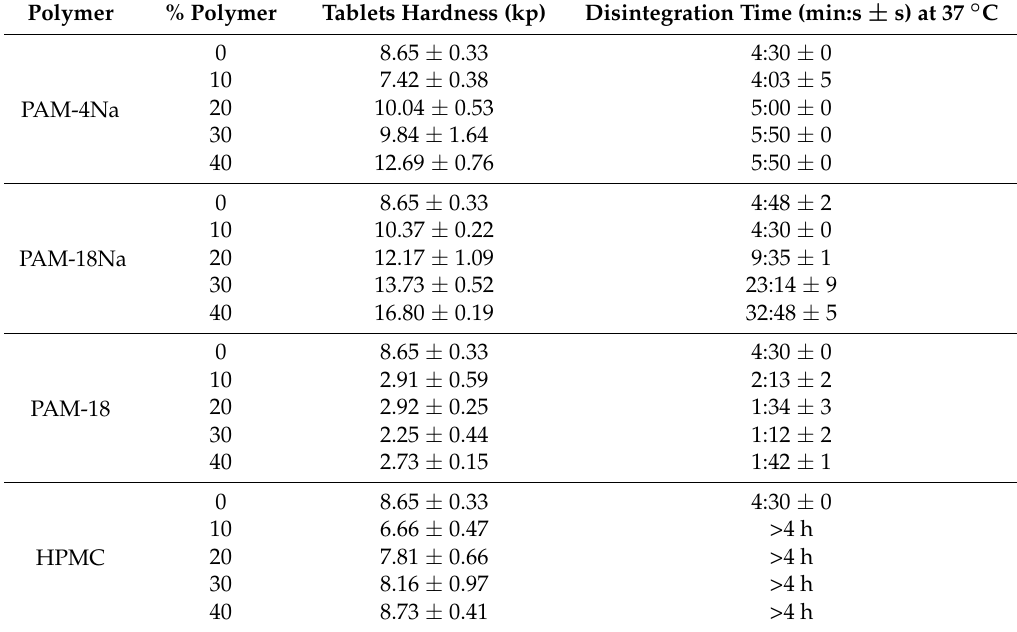
Table 1. Results of hardness and disintegration time for the tablets of ampicillin trihydrate at different polymer